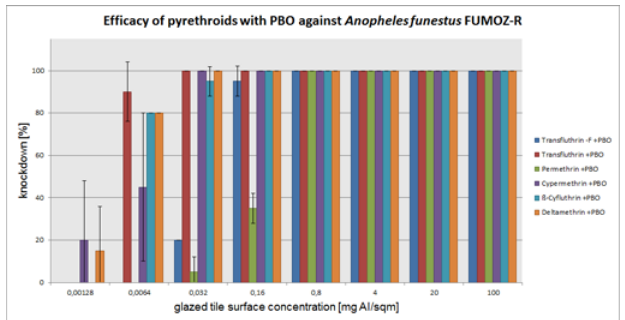
Fig 8. Arithmetic means and standard deviations of the 1 h results of a glazed tile contact bioassay using technical grade pyrethroids with PBO (1600 ppm) against the metabolic resistant Anopheles funestus FUMOZ-R